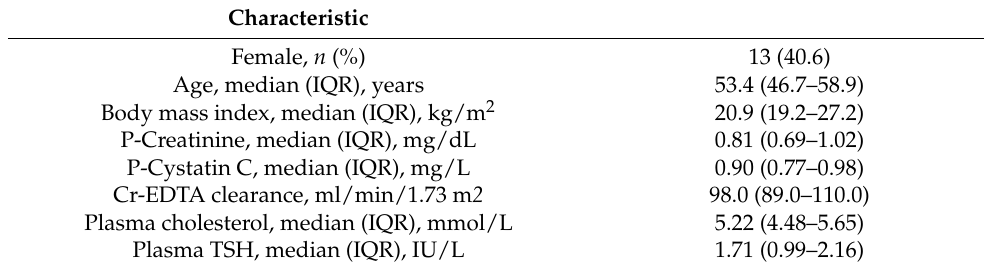
Table 1. Patient characteristics for all included patients ( n = 32)